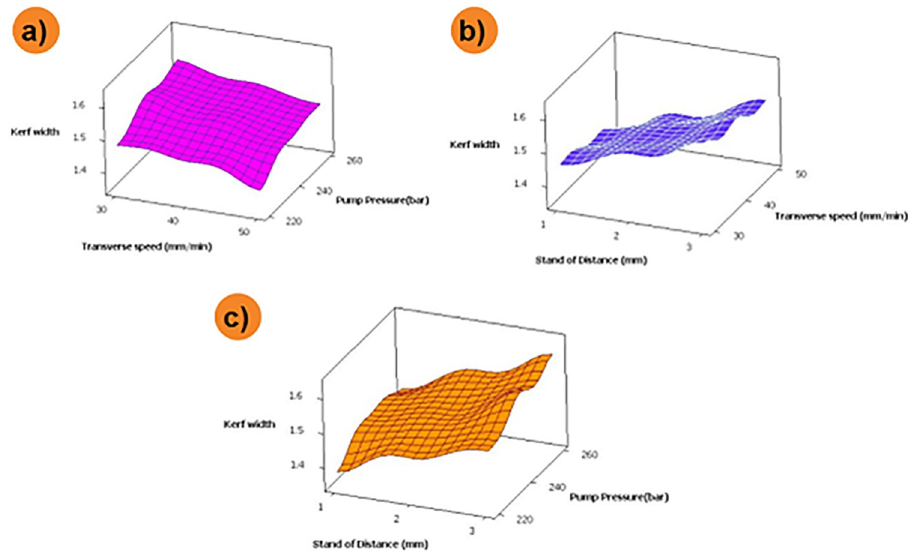
Fig 9. Influence of AWJM parameters on kerf width for 0.1 wt. % of filler loaded composite.